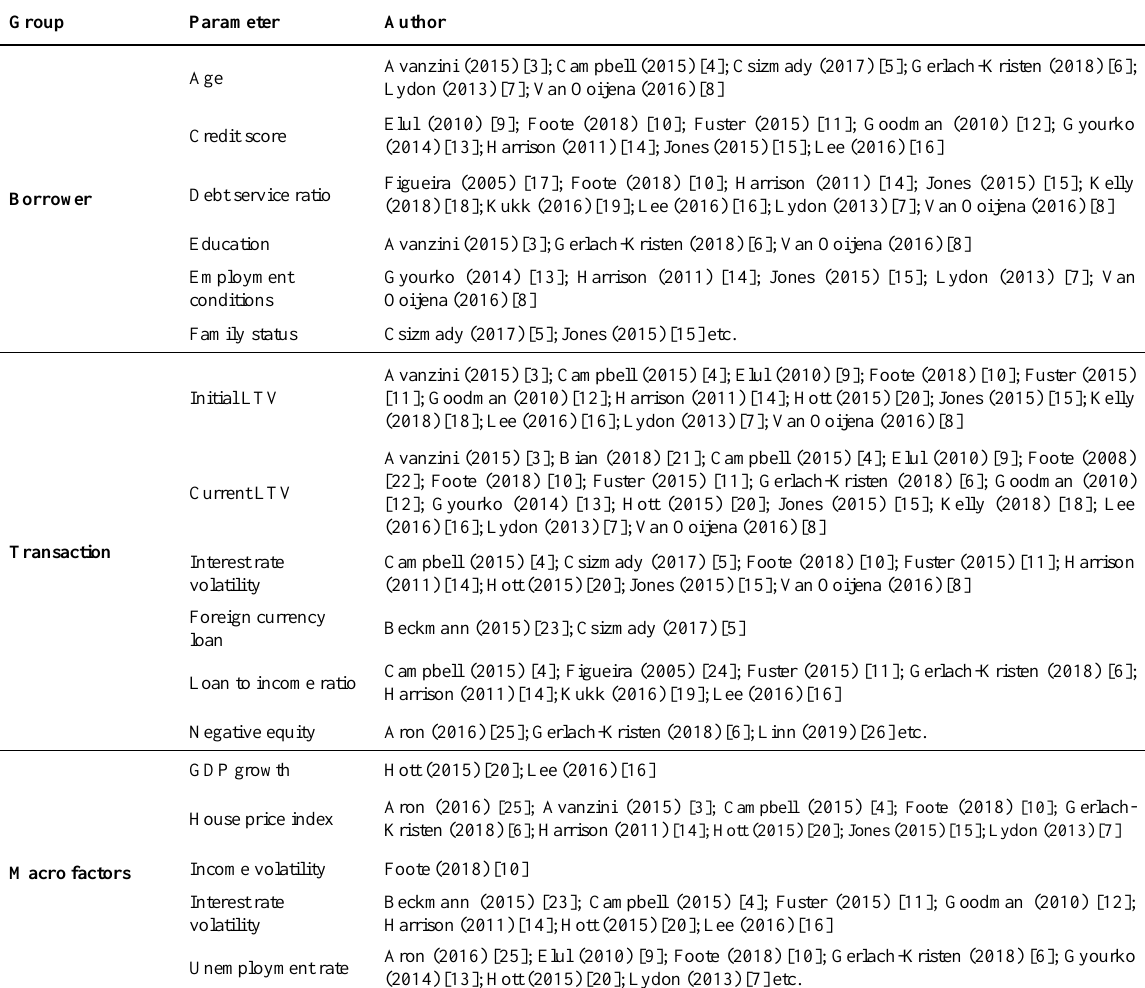
Table 1. Residential mortgage loans delinquencies affecting factors analysis summary from literature